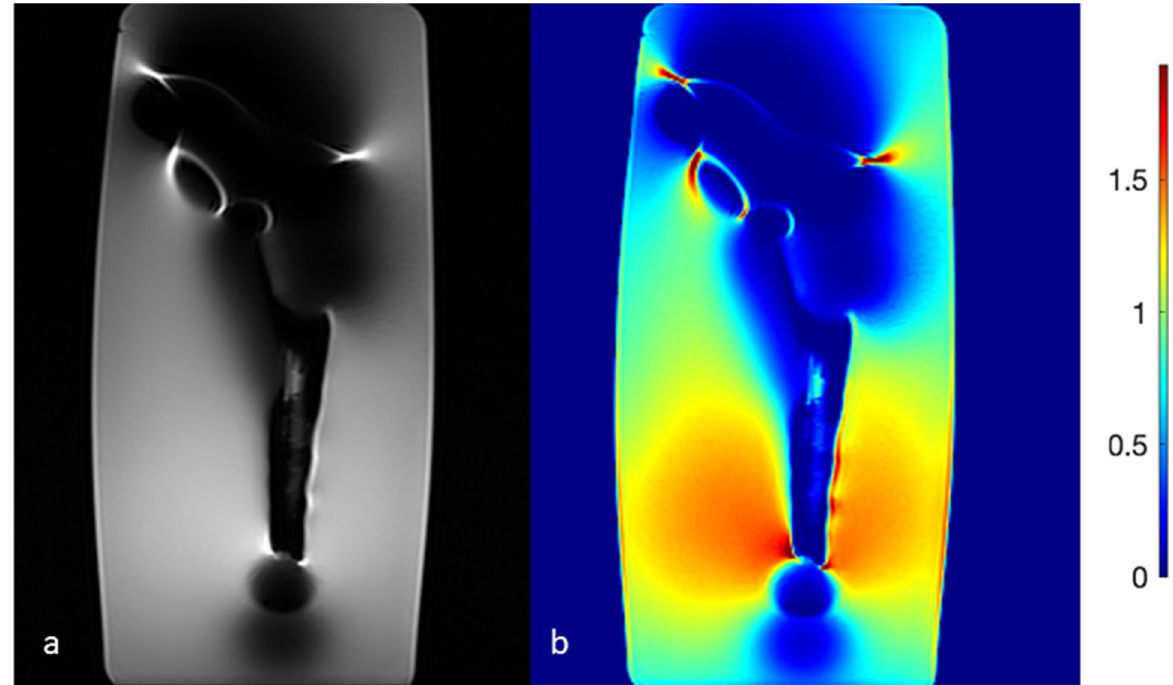
Fig. 2 Coronal T2‑weighted turbo spin‑echo image of an implant (Fe‑Cr) at 1.5 T ( a ) with the normalized signal intensity on the right ( b